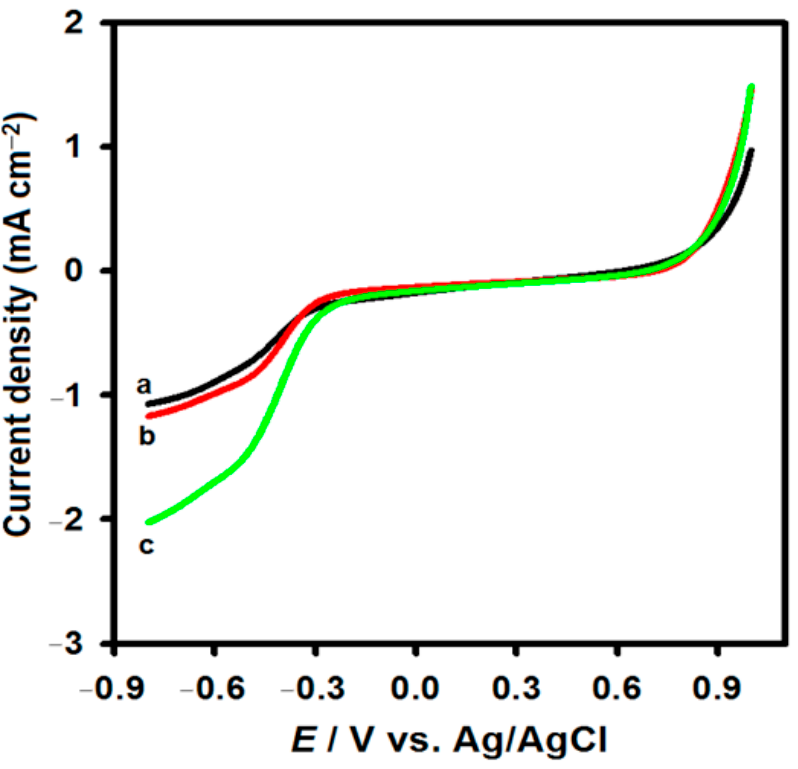
Figure 7. LSV polarization curves for ORR/OER activity at LaMnO 3 @C ( a ), LaMnO 3 @C-RuO 2 ( b ), and LaMnO 3 @C-Co 3 O 4 ( c ) in O 2 -saturated 0.1 M KOH electrolyte at a scan rate of 20 mV s − 1 with rotation speed of 1600 rpm.